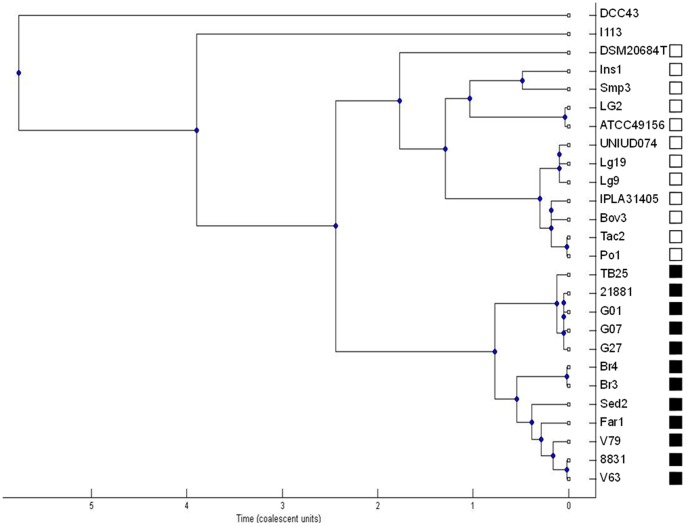
Major rule consensus tree based on Clonal Frame analysis of concatenated sequences of all loci, for the total population.The X-axis represents the estimated time to the most recent common ancestor of L. garvieae. Open and closed squares correspond to subgroups SB and SA, respectively.